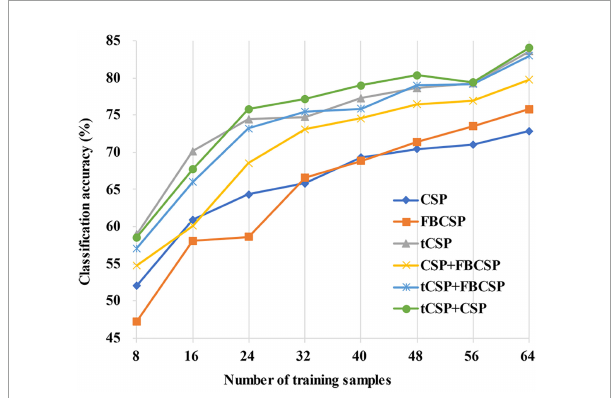
FIGURE7 The variation trend of average classification accuracies with different training sample sizes. The classification accuracies rise with the increase of training samples for all methods. The proposed methods achieve better classification performance than the others, even in small-sample setting conditions.